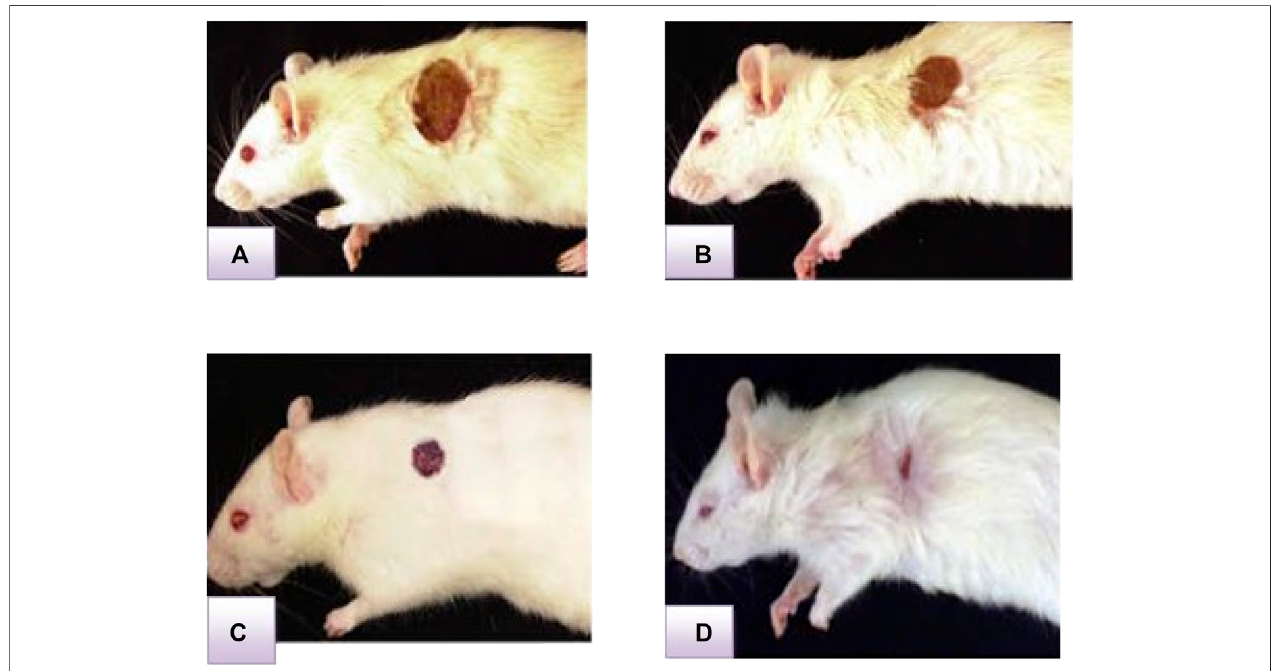
FIGURE4| Representativeimageofthewoundhealingprocess intheexcisionwoundmodel atECGHD 2%w/wonthe4 th (A) ,8 th (B) ,12 th (C) ,and 16 th (D) days of